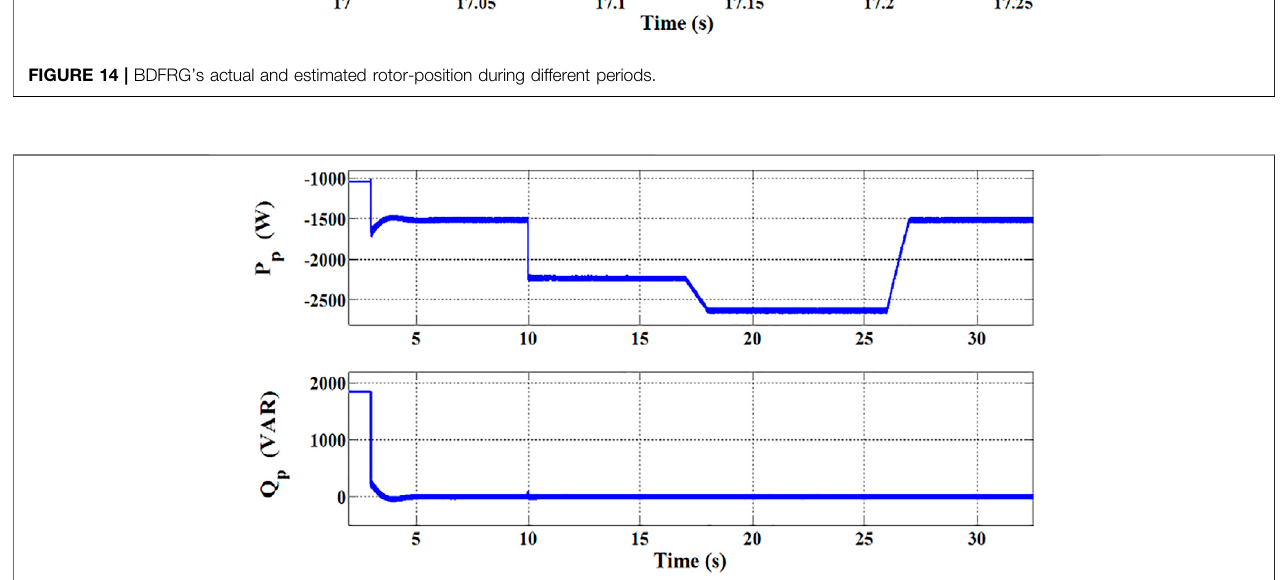
FIGURE 15 | Active and reactive power of generator